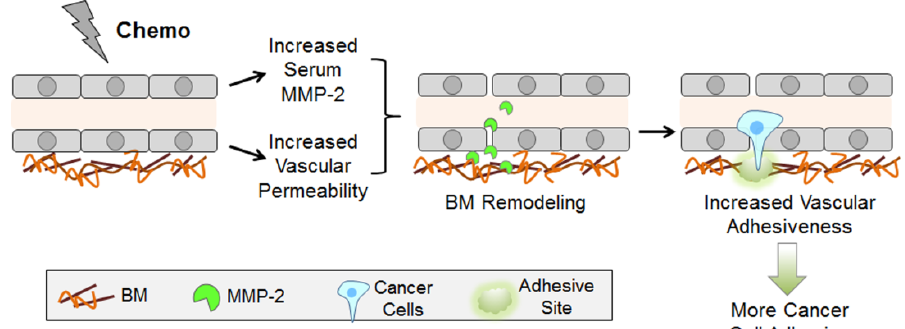
Figure 9. A model. See text for details. BM: basement membrane.